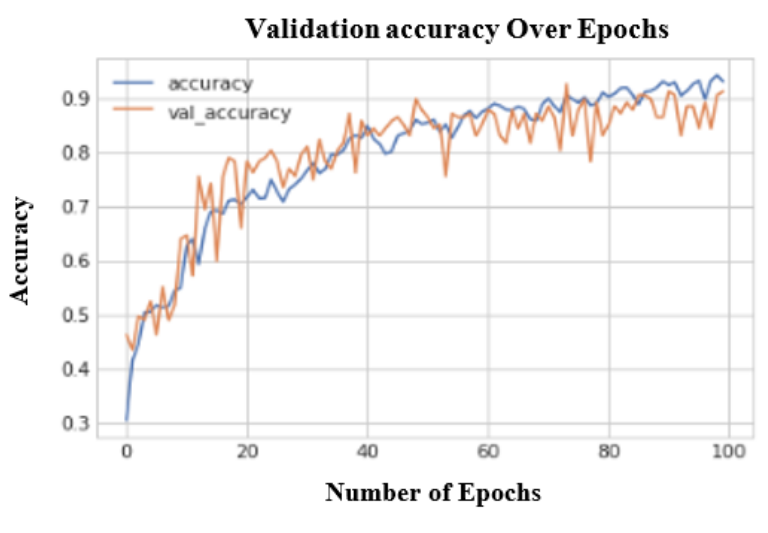
Figure 8. Training